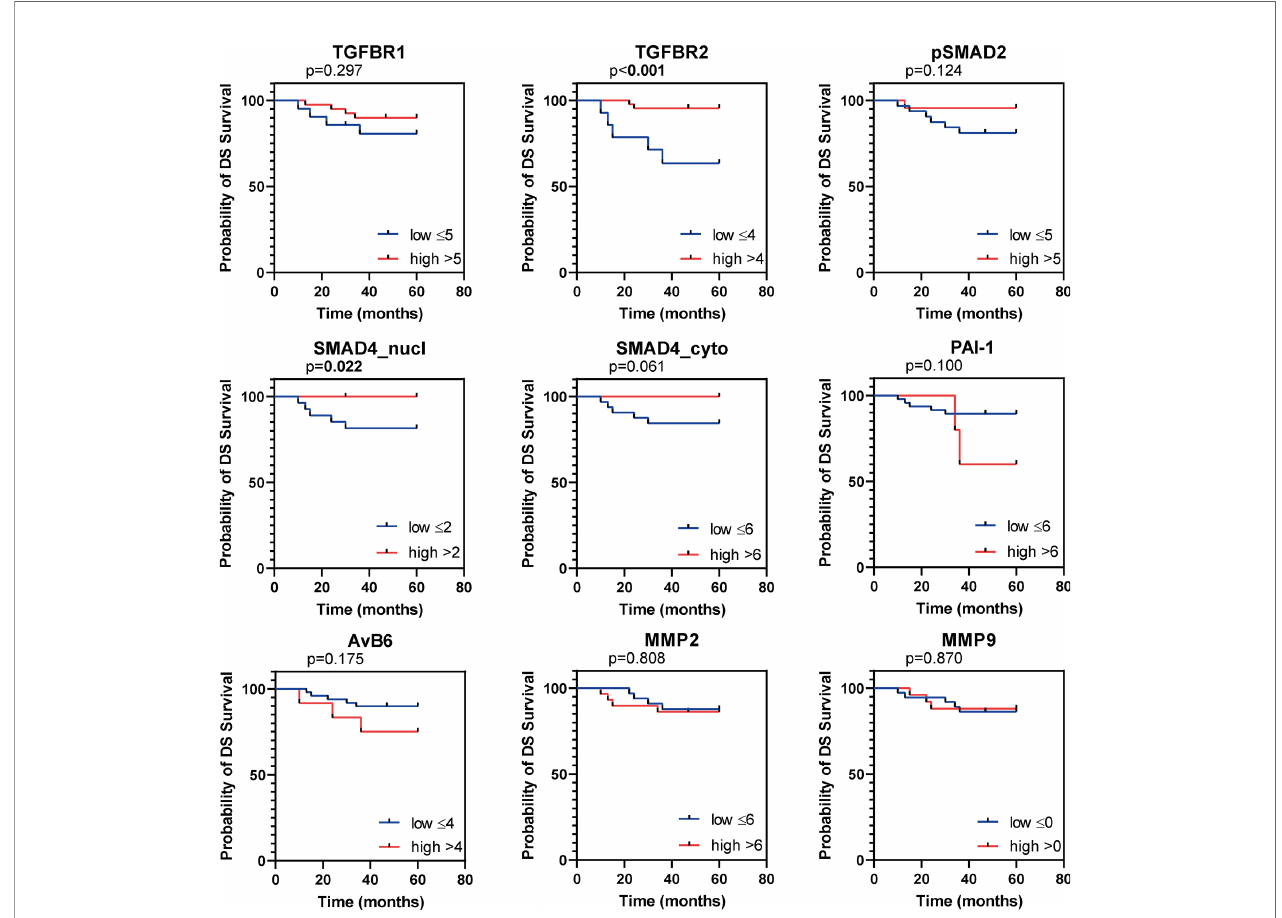
FIGURE 4 | Kaplan Meier fi gures for disease speci fi c survival (DSS). Kaplan Meier curves for DSS of the institutional AC cohort, dichotomized as indicated by the numbers in the legend. P values based on log-rank test, bold indicates signi fi cance (p ≤